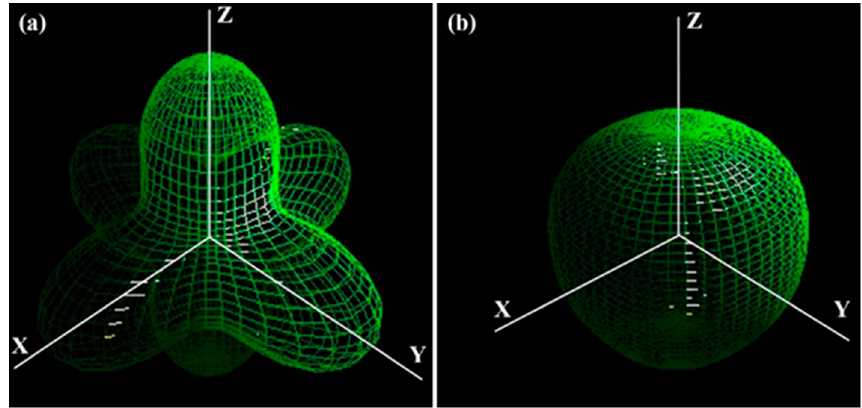
Figure 9. Crystallite shapes of Ni deposits in the pure Ni ( a ) and Ni-25–Cr-8–graphene ( b ) coatings obtained from Rietveld refinements.